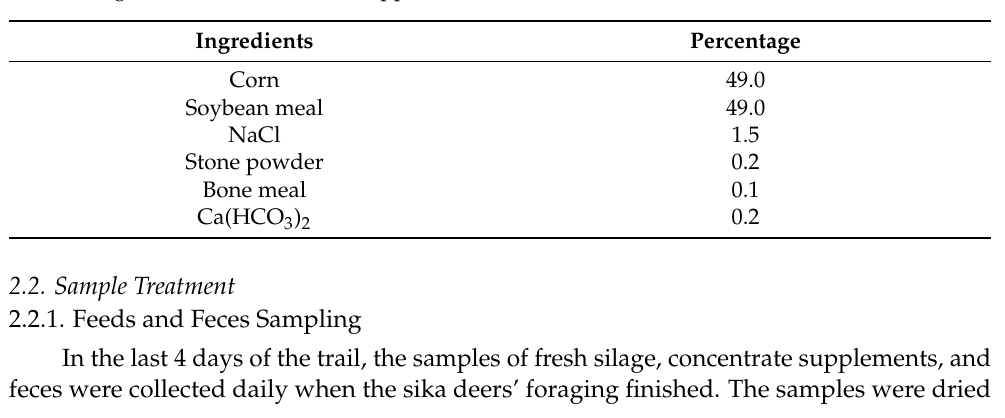
Table 1. Ingredients of concentrate supplement